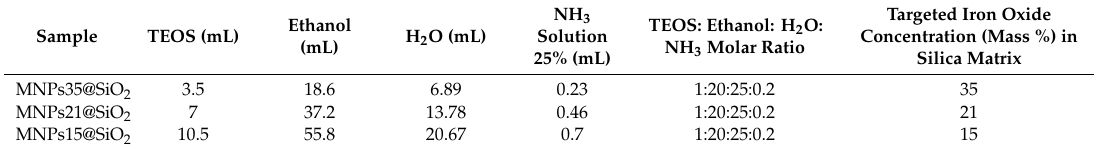
Table 1. Summary of synthesis